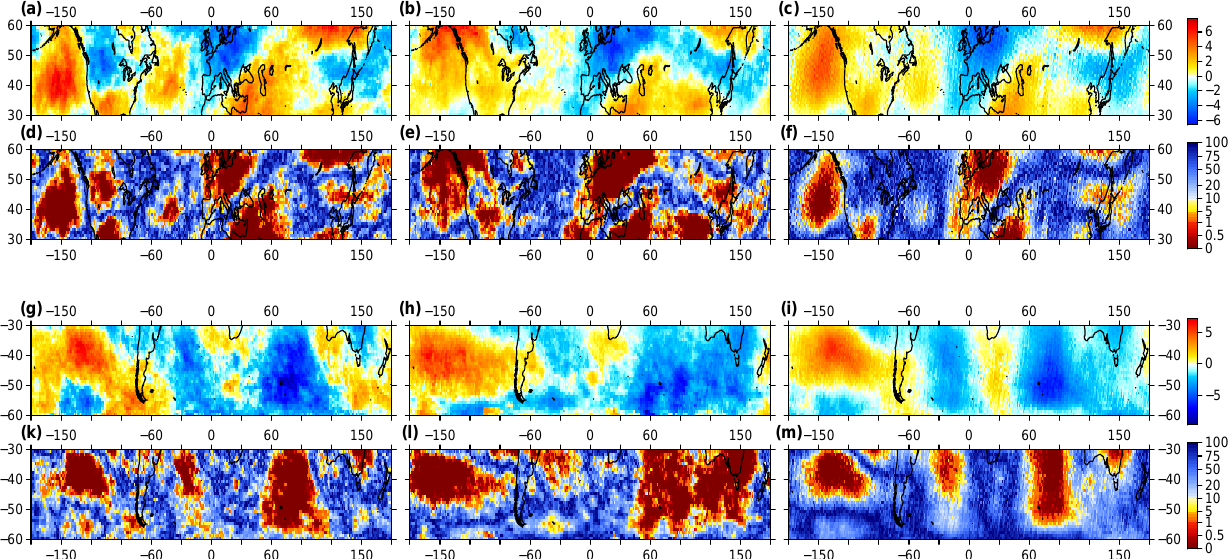
Fig. 2. Pointwise regression coefficient estimates (in DU ( unitENSO ) − 1 ) for the El Ni˜no/Southern Oscillation for (a) EHOs, (b) ELOs, and (c) mean values of total ozone during winter (DJF) at 30 ◦ N to 60 ◦ N; (d) – (f) show the p -values of pointwise significance tests for the estimates in (a) – (c) . (g) – (m) as (a) – (f) but during winter (JJA) at 30 ◦ S to 60 ◦ S. An augmented version of this figure including standard errors for all coefficient estimates is provided in Fig. S2.